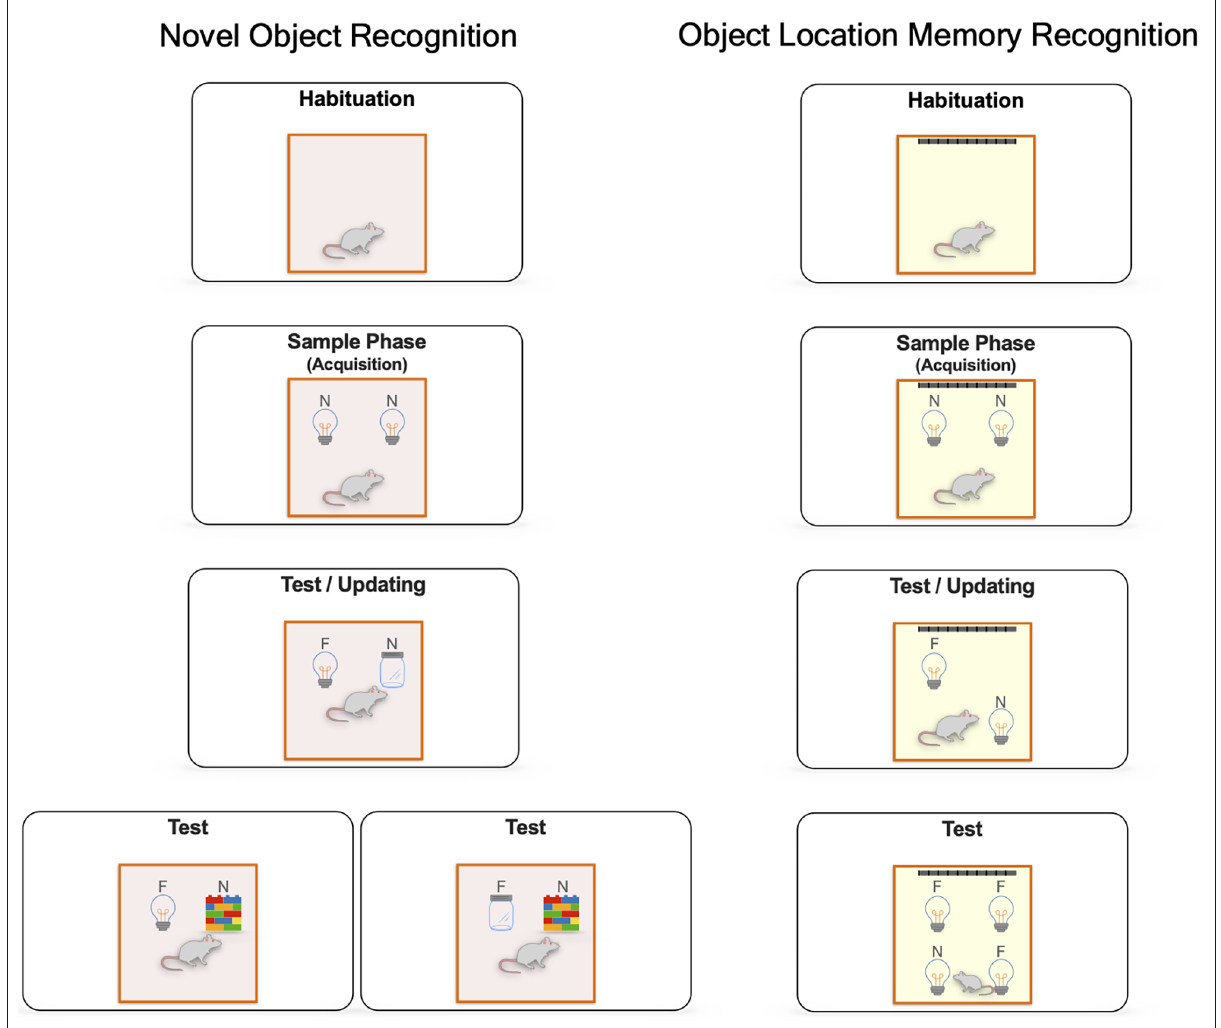
FIGURE1 General procedures for spontaneous object exploration. Novel object recognition (NOR) and object location recognition memory (OLRM) paradigms include different sessions: a handling and habituation period to an empty open field to reduce stress and promote the exploratory activity;asamplephase,wheretheanimalisgivenaperiodtofreelyexploretwoidenticalobjects.Duringthetestsession,short-termorlong-term assessment of recognition memory is determined by the length of the retention interval, in this session the animal freely explores a different novel object (jar) in the case of NOR or the displacement of an object to a novel location in the case of OLRM. Finally, recognition memory updating is evaluated if a new third object is presented (wall of brick toys) in a NOR task or when a new displaced position is presented in an OLRM task. In general, animals that remember the familiar object of the familiar spatial configuration will spend more time exploring the novel object or the novel spatial configuration Novel (N) and Familiar